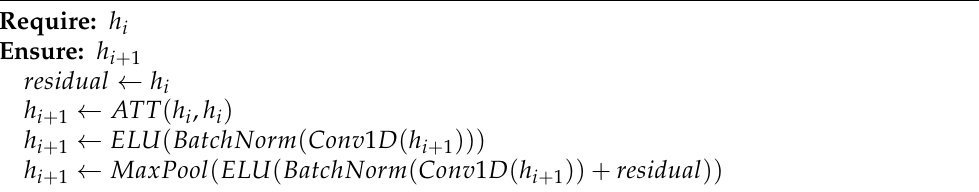
Algorithm 1 ResInformer ProbSparse Self-Attention